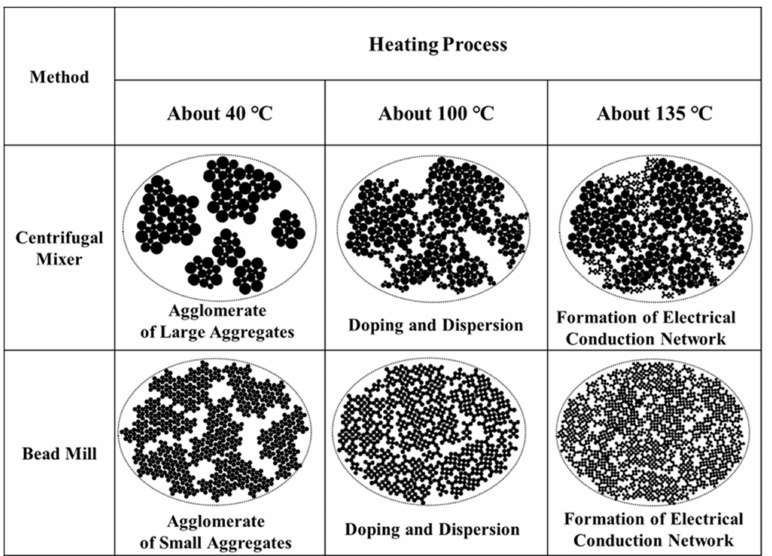
Figure 5. Diagrams summarizing the effects of the mixing method on thermally-induced dispersion and doping in the PANI/DBSA